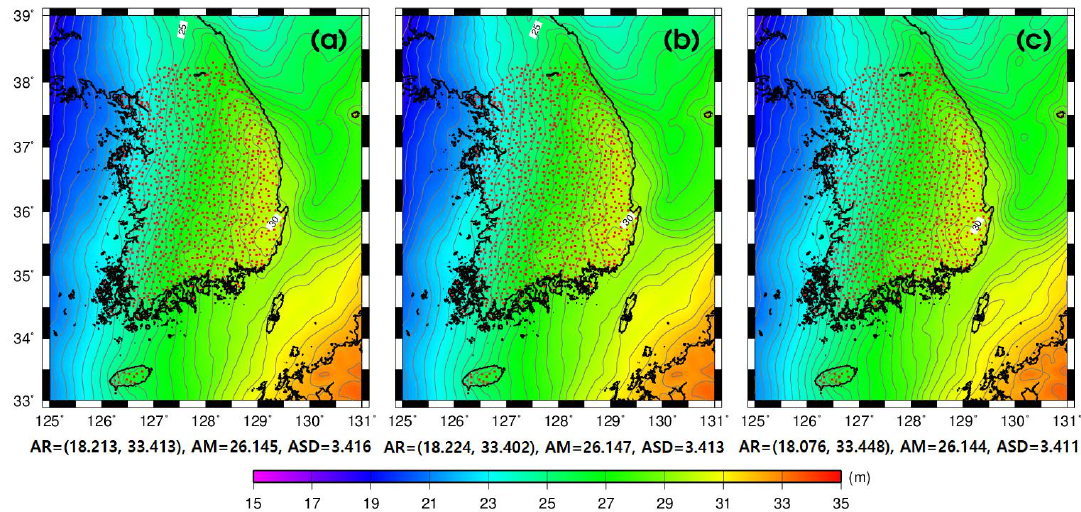
Figure 2. The 1′ gridded geoid height (𝑁 𝐺𝐺𝑀 ) derived from the three GGMs (max. degree 2190). ( a ) GECO; ( b ) EIGEN-6C4; and ( c ) EGM2008. The attributes listed for this and subsequent maps include the amplitude range (AR = minimum and maximum values), amplitude mean (AM), and amplitude standard deviation (ASD). The red dots represent the locations of the 1182 GNSS/leveling UCPs.